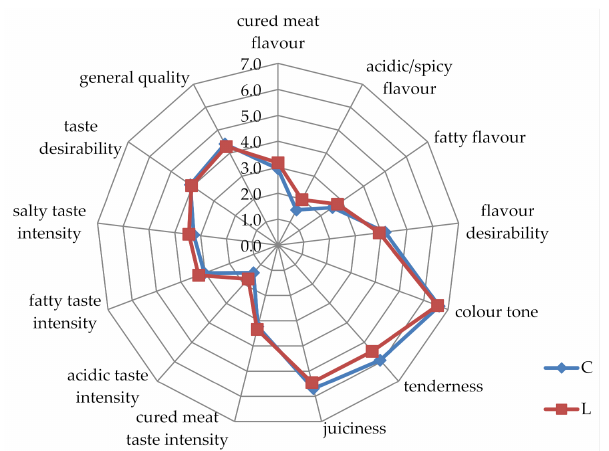
Figure 1. Sensory evaluation of MSPM sausages after production. C—control treatment with MSPM without a bacteria strain, L—treatment with MSPM and the bacteria L. plantarum SCH1 (10 7 cfu/g); No significant statistical differences were found ( p > 0.05).